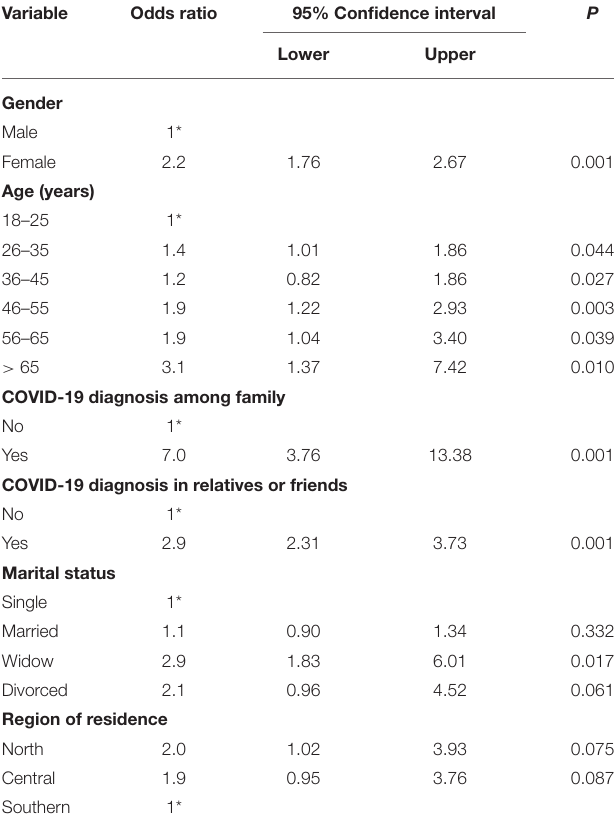
TABLE 2 | Cross-tabulation of factors associated with the Impact of Event Scale – Revised score. Total score categories